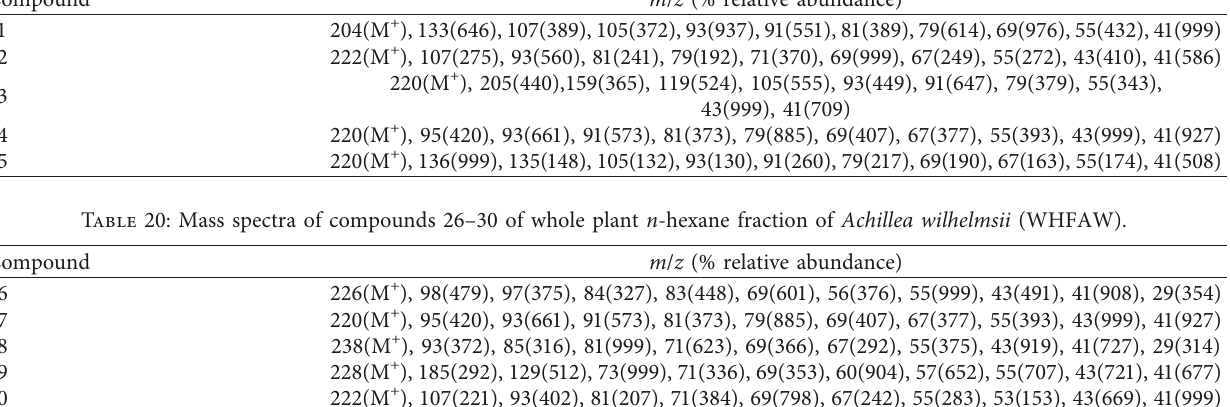
Table 19: Mass spectra of compounds 21–25 of whole plant n -hexane fraction of Achillea wilhelmsii (WHFAW).